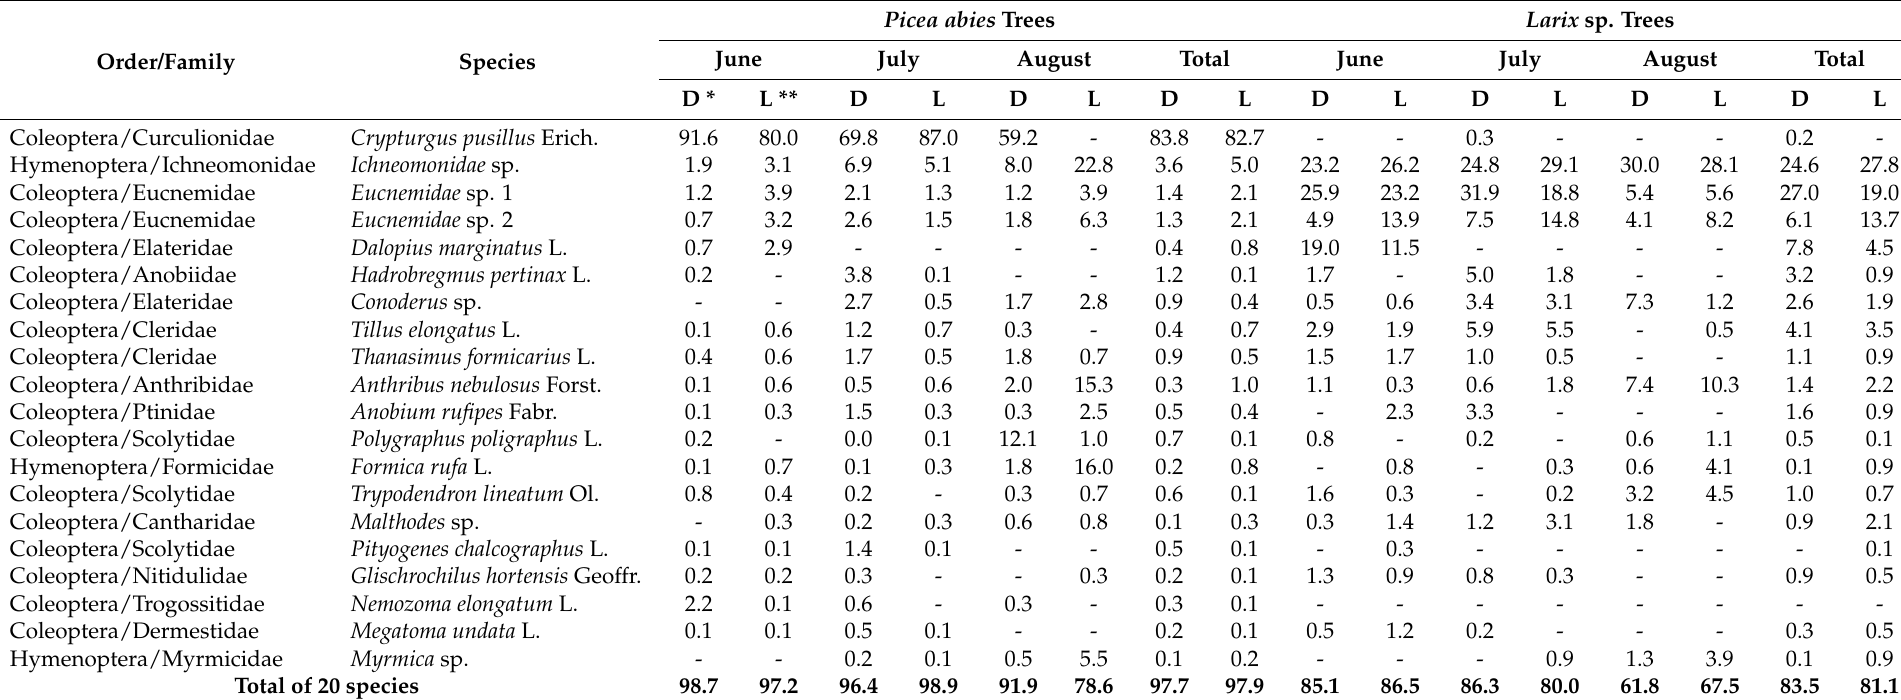
Table 3. Relative abundance (%) of the 20 most common insect species trapped using sticky traps. All study sites are